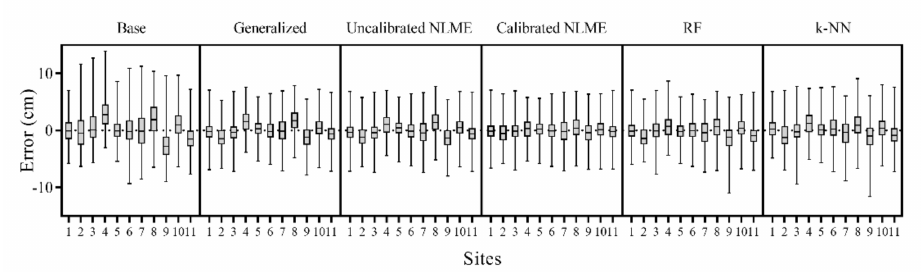
Figure 6. The boxplots of errors (cm) among different models and 11 sites.